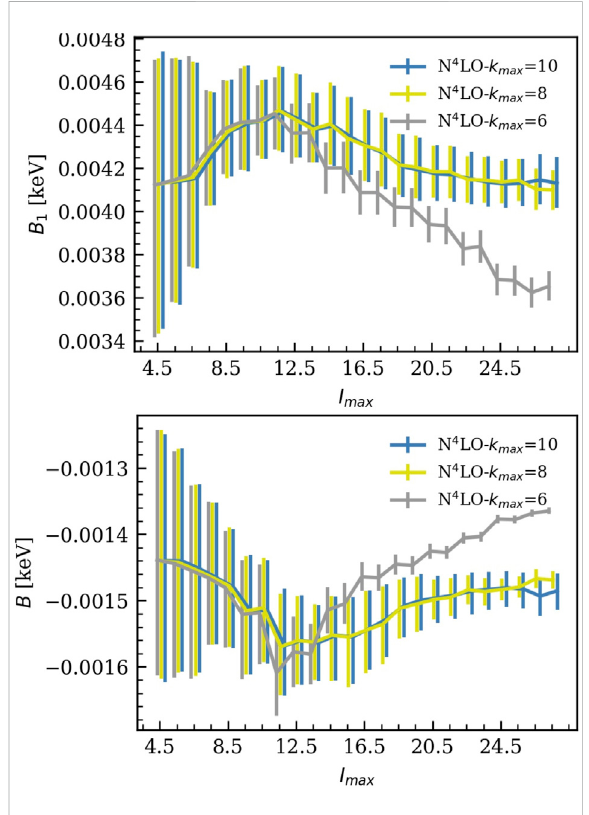
FIGURE 5 Posteriors for B 1 and B describing 239 Pu a function of I max for different values of k max . The solid line connects the median values and the error bands encompass the 16th and 84th percentiles in the marginalized distribution.